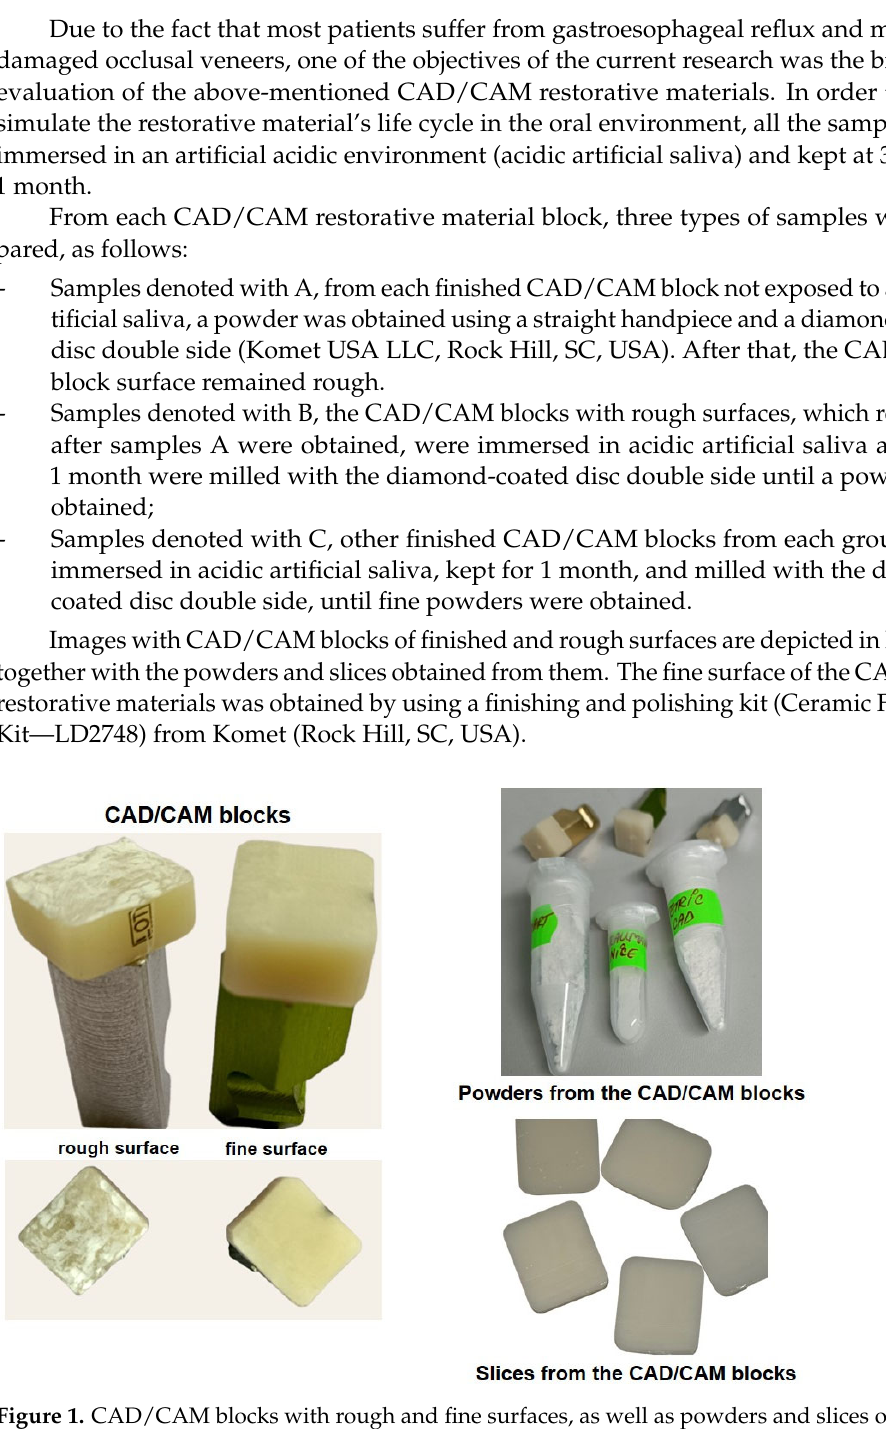
Table 2. The CAD/CAM restorative materials tested in vitro